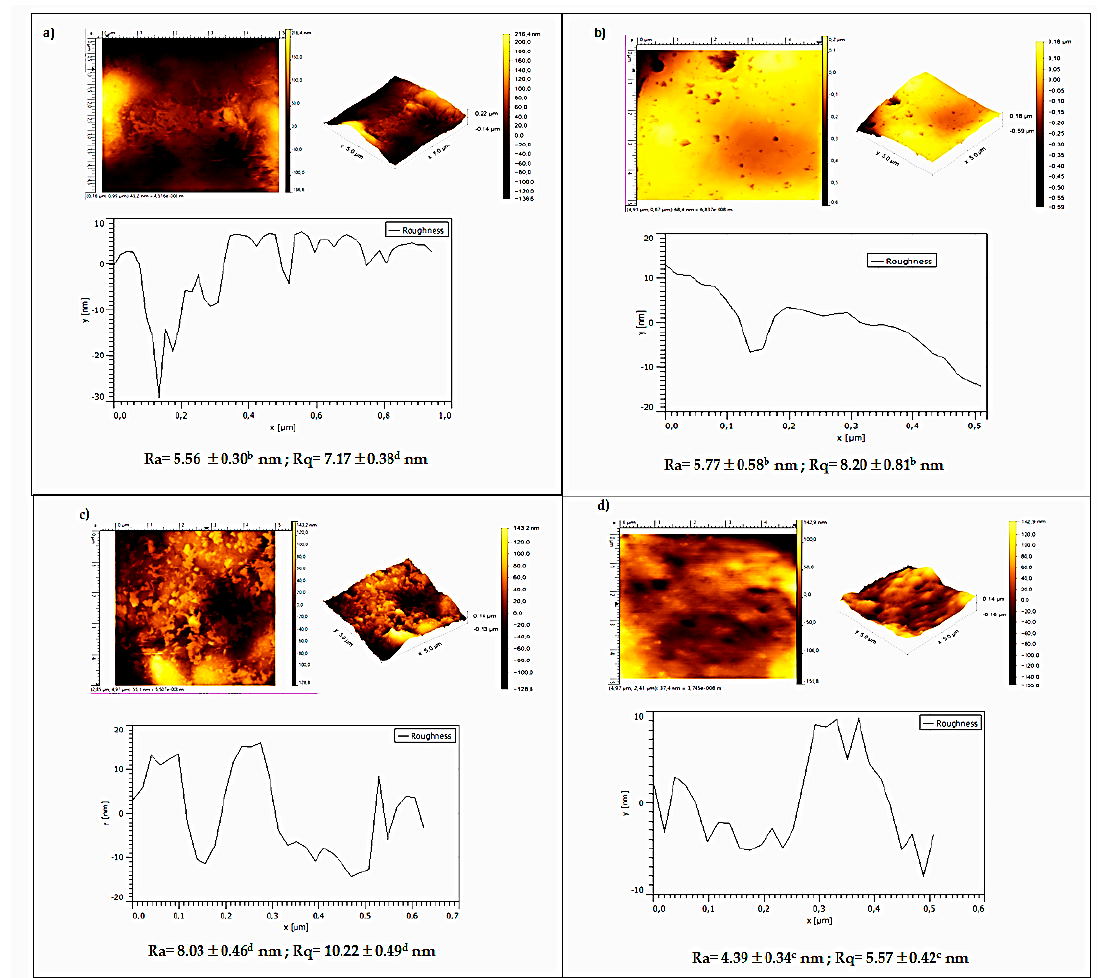
Figure 4. AFM micrographs of chitosan-quinoa protein edible films. ( a ) QP; ( b ) QP + TG; ( c )